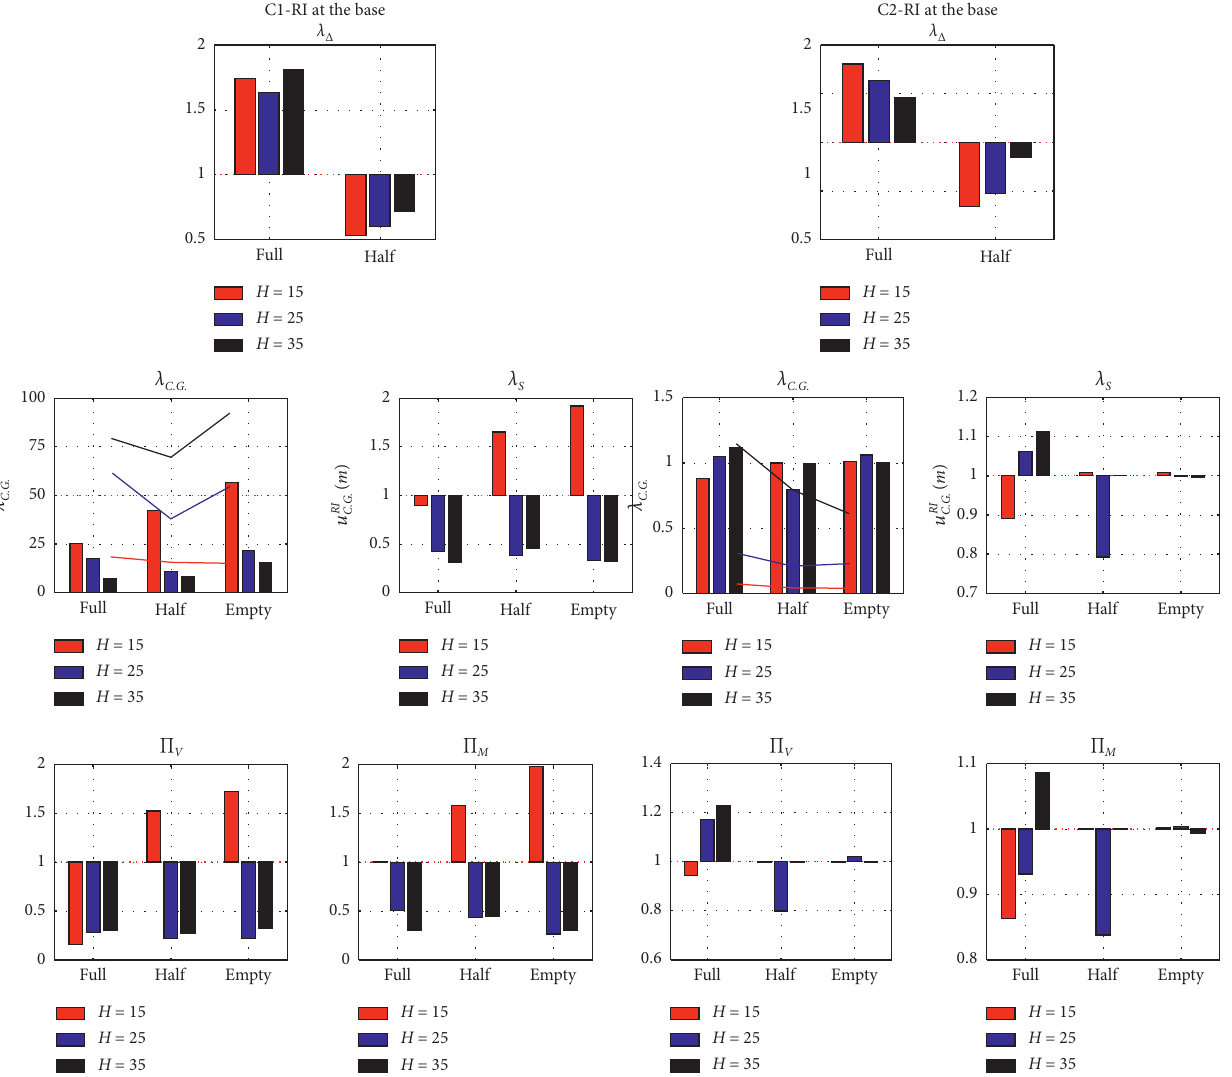
Figure 22: Maximum performance parameters of the prototypes with various “tank filling levels” (full, half, and empty) and “shaft heights” (15, 25, and 35